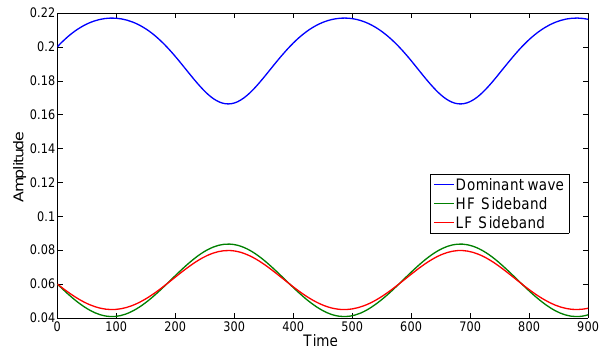
Fig. 2. Nonlinear evolution of a 3-wave system: p = 0 . 2; q = 0; θ = 0 . 7 π ; ε = 0 . 2; c 1 = c 2 = 0 .